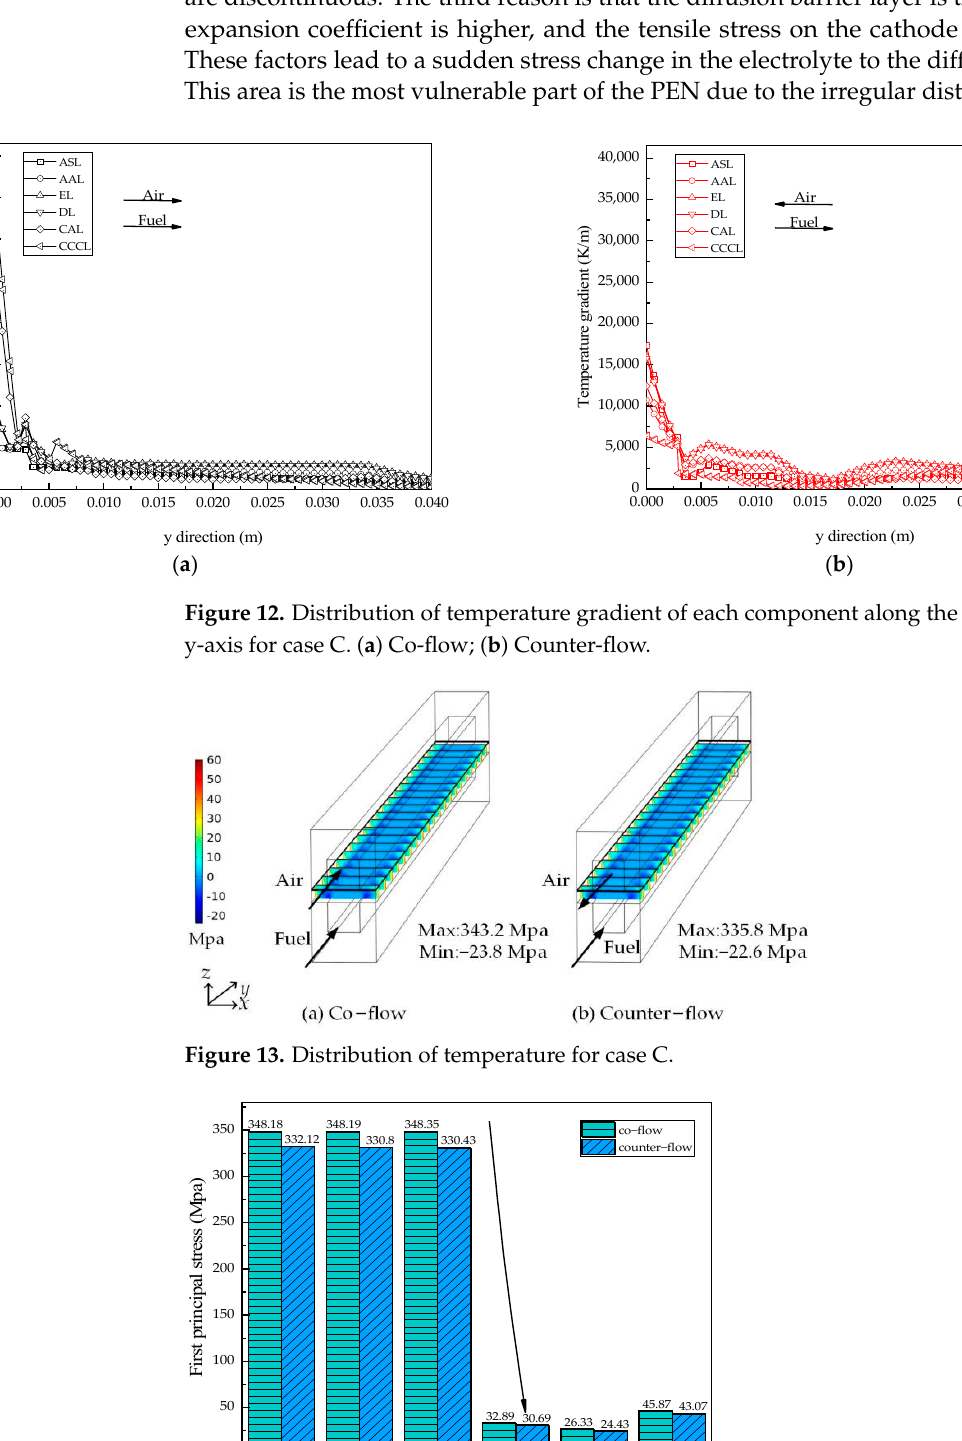
Figure 11. Distribution of temperature of each component along the forward direction of y-axis for case C. ( a ) Co-flow; ( b ) Counter − flow.